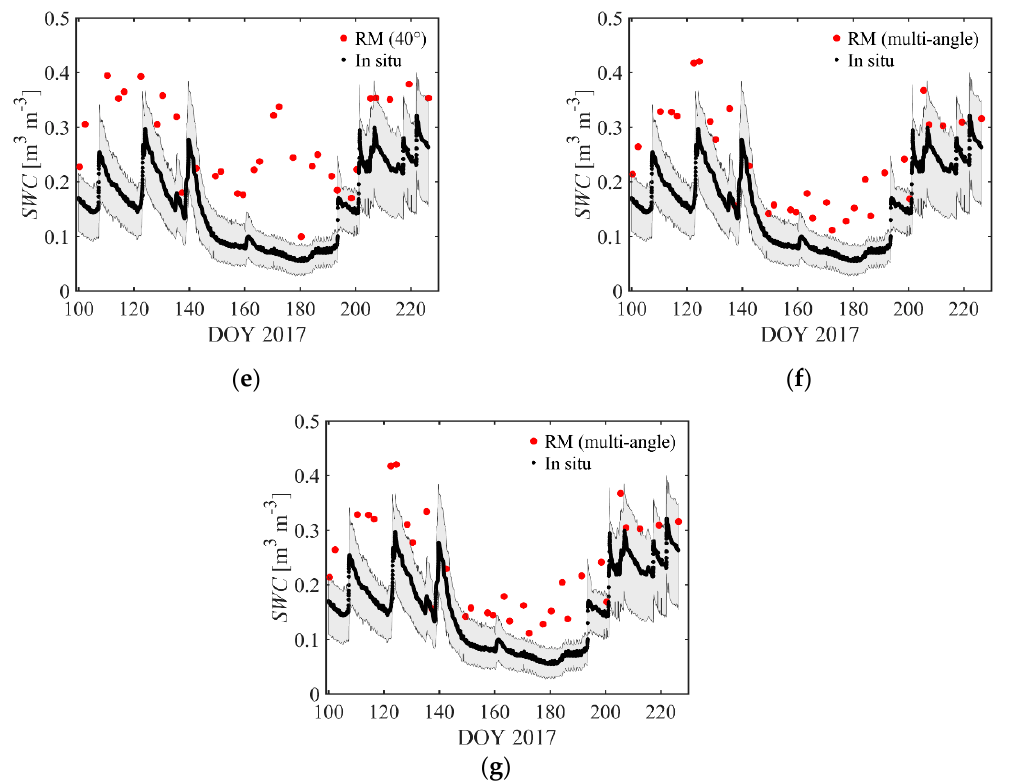
Figure 11. Volumetric soil water content ( SWC ) [m 3 m − 3 ] retrieved from T B observations over the non-gridded plot using different retrieval schemes (see Table 1) with the τ - ω model. Inversions were performed using either the single-angle approach (40° incidence angle) ( a , c , e ) or the multi-angle approach (from 40° to 60° incidence angle) ( b , d , f , g ). The retrieval schemes depicted here are, namely, the 1-P retrieval scheme ( a , b ), the 2.1-P retrieval scheme ( c , d ), the 2.2-P retrieval scheme ( e , f ), and the 3-P retrieval scheme ( g ). The estimated SWC values are compared to the in situ measured SWC in 5 cm depth. The grey shaded areas represent the 75% quintile of the in situ sensors.